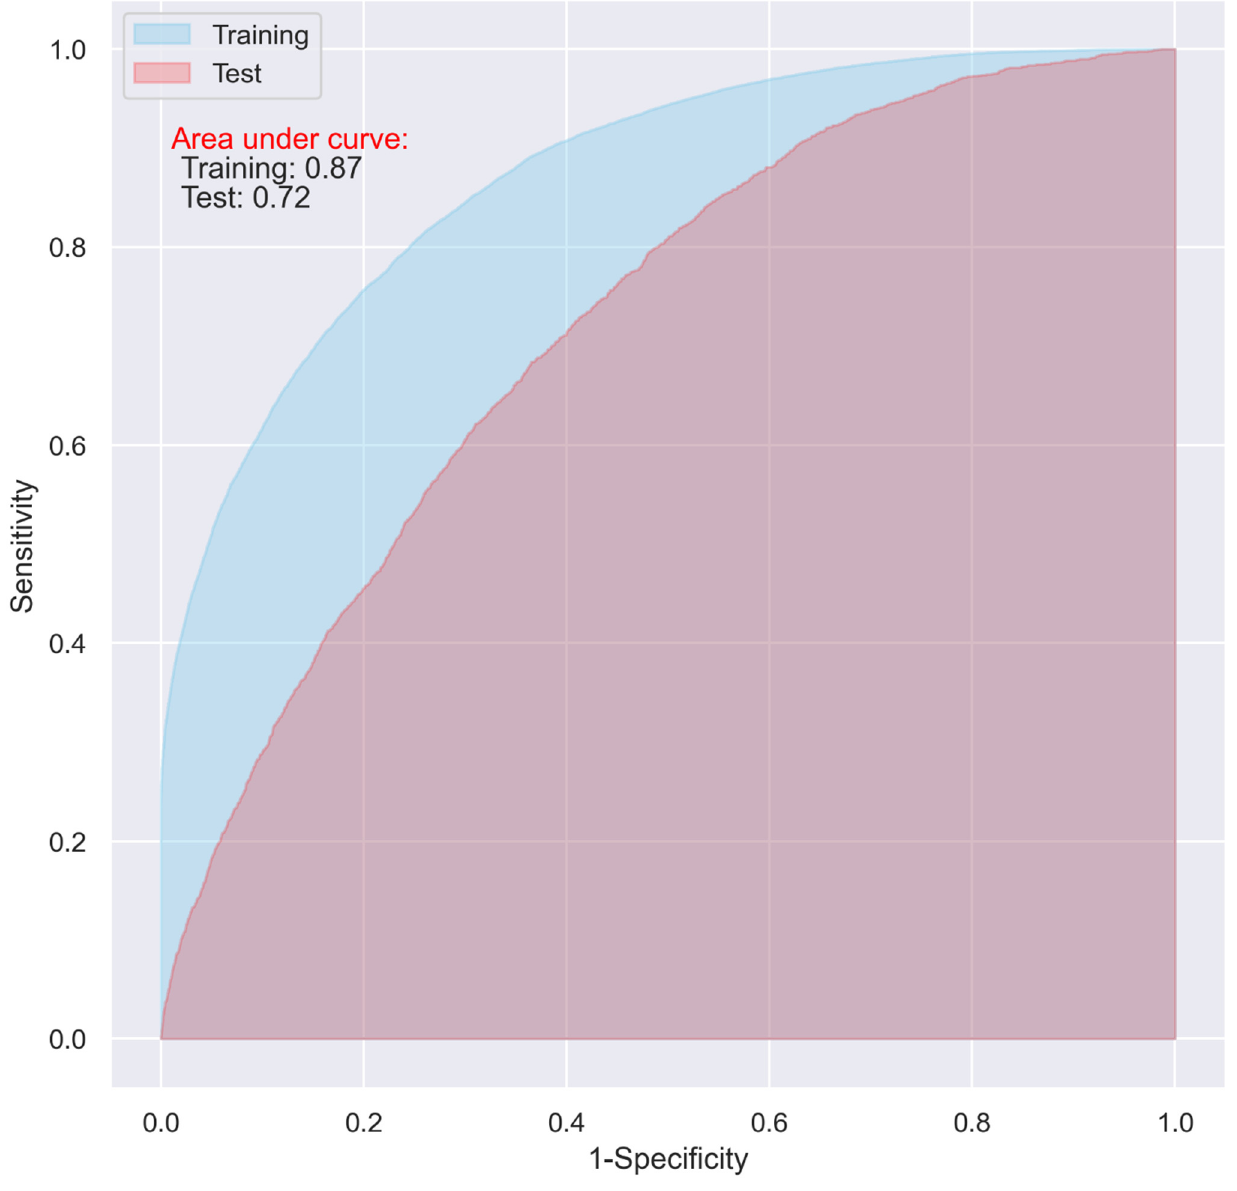
Figure 1. ROC of the CNN model including all the variables.